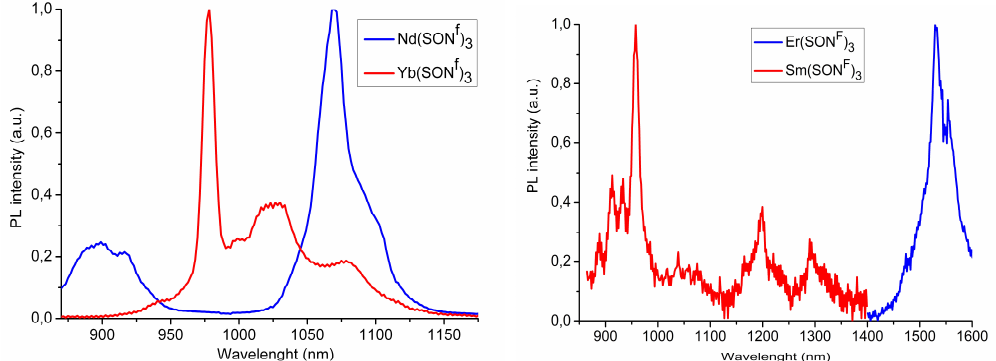
Figure 9. Normalized PL spectra of the solid samples of the complexes 3 , 4 , 7 , and 8 ( λ exc = 405 Figure 9